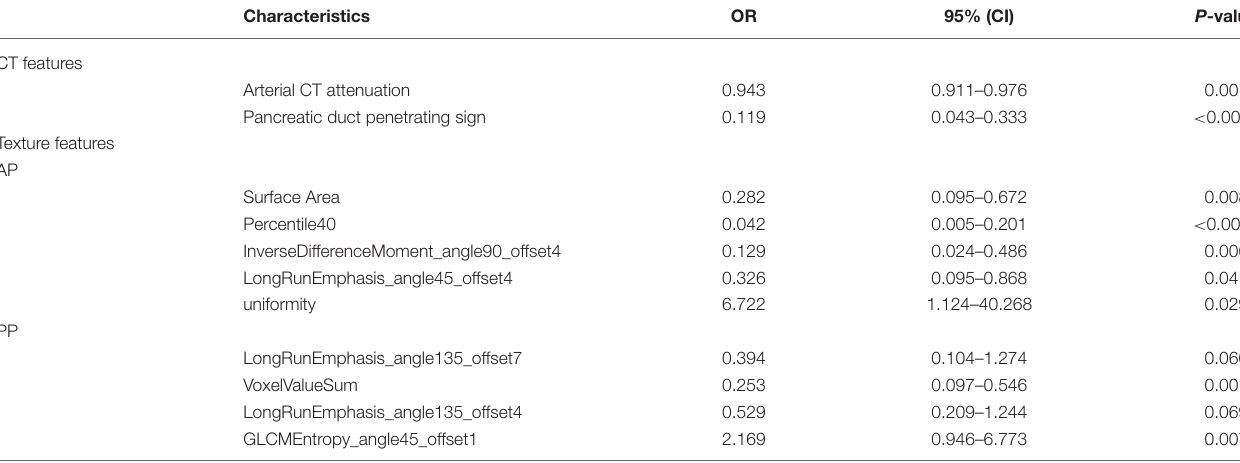
TABLE 3 | Multivariate analyses of CT imaging and texture parameters in differentiating MFP from PDAC.